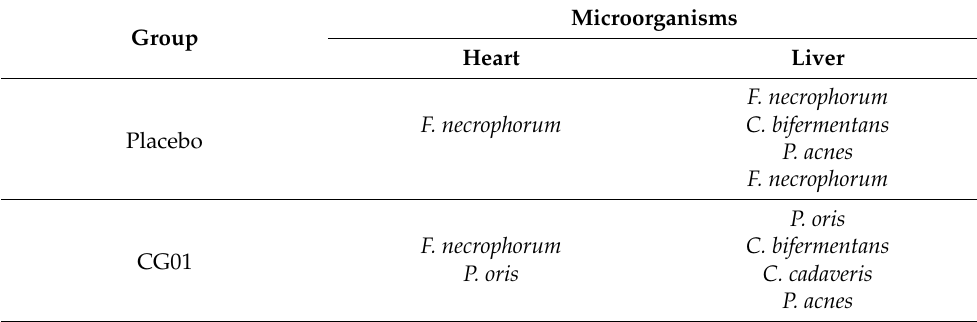
Table 3. Results of mass spectrometry identification of anaerobic microorganisms in the necropsy material of rabbits.